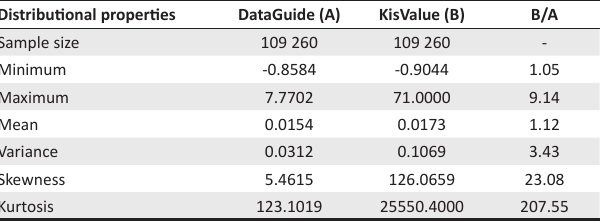
TABLE 4: The effect of large errors on distributional properties of monthly stock returns. Distributional